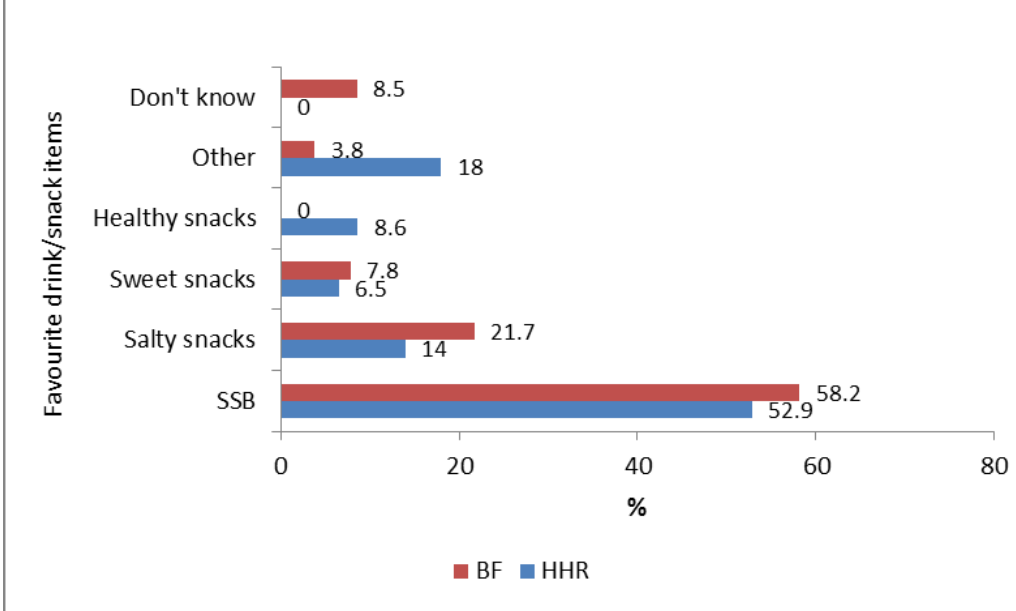
Figure 10. Most favourite snack/drink of household respondents (HHR n = 92) and learners’ perception of their best friend’s favourite snack/drink (BF n = 153).